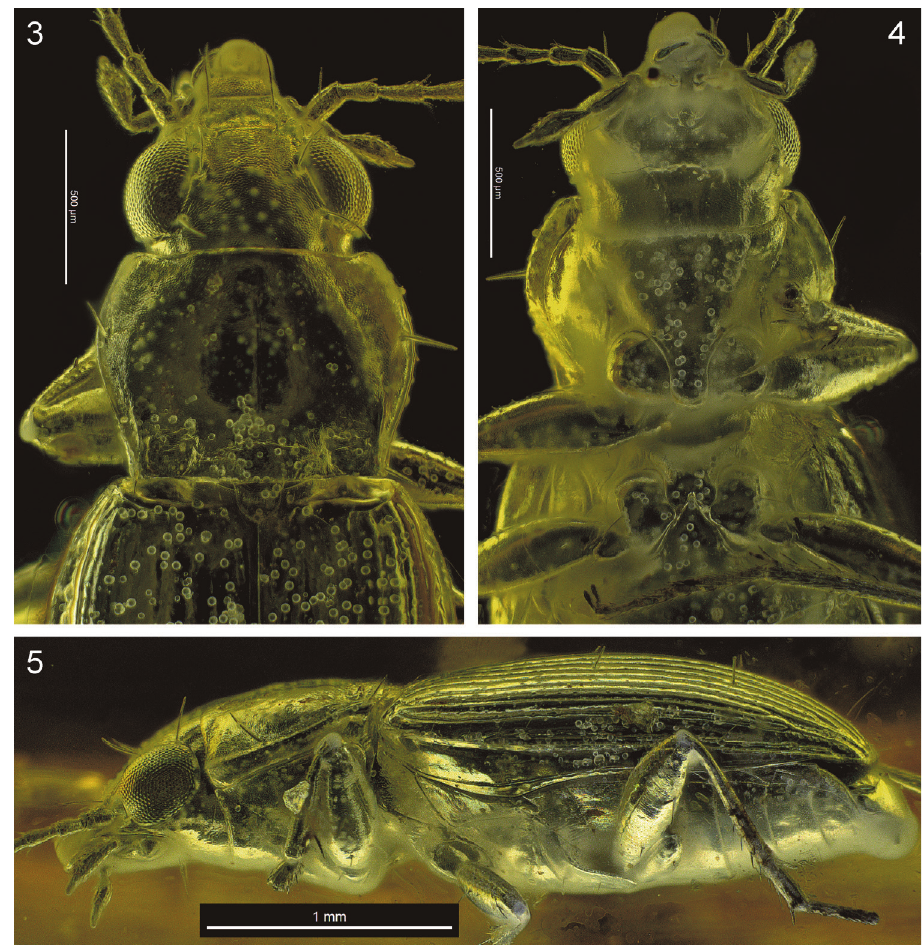
Figures 3–5. Bembidion bukejsi sp. n., light microscopic images of the holotype. 3 anterior portion of body, dorsal aspect 4 anterior portion of body, ventral aspect 5 left lateral aspect. Disk moderately convex, smooth apart from the prominent microsculpture. Frontal furrows very shallow, very short, absent on disk. Supraorbital furrows flat, without punctures; two supraorbital setae present and in normal position for Bembidion . Prothorax: Pronotum moderately large, length 0.76 mm, width 1.04 mm, trans- verse (width/length = 1.37), 1.3 times broader than head, subcordate, broadest slightly before middle, with sides faintly concave in posterior third. Laterobasal angles large, almost rectangular, not protruded laterally. Basal margin 1.1 times broader than apical margin. Disk moderately convex, smooth. Anterior margin finely convex in middle, lateroapical angles distinctly protruded, rounded. Posterior margin not beaded, slight- ly convex in middle, slightly sinusoidal towards laterobasal angles, latter very faintly shifted anteriad with respect to posterior margin of pronotum. Median